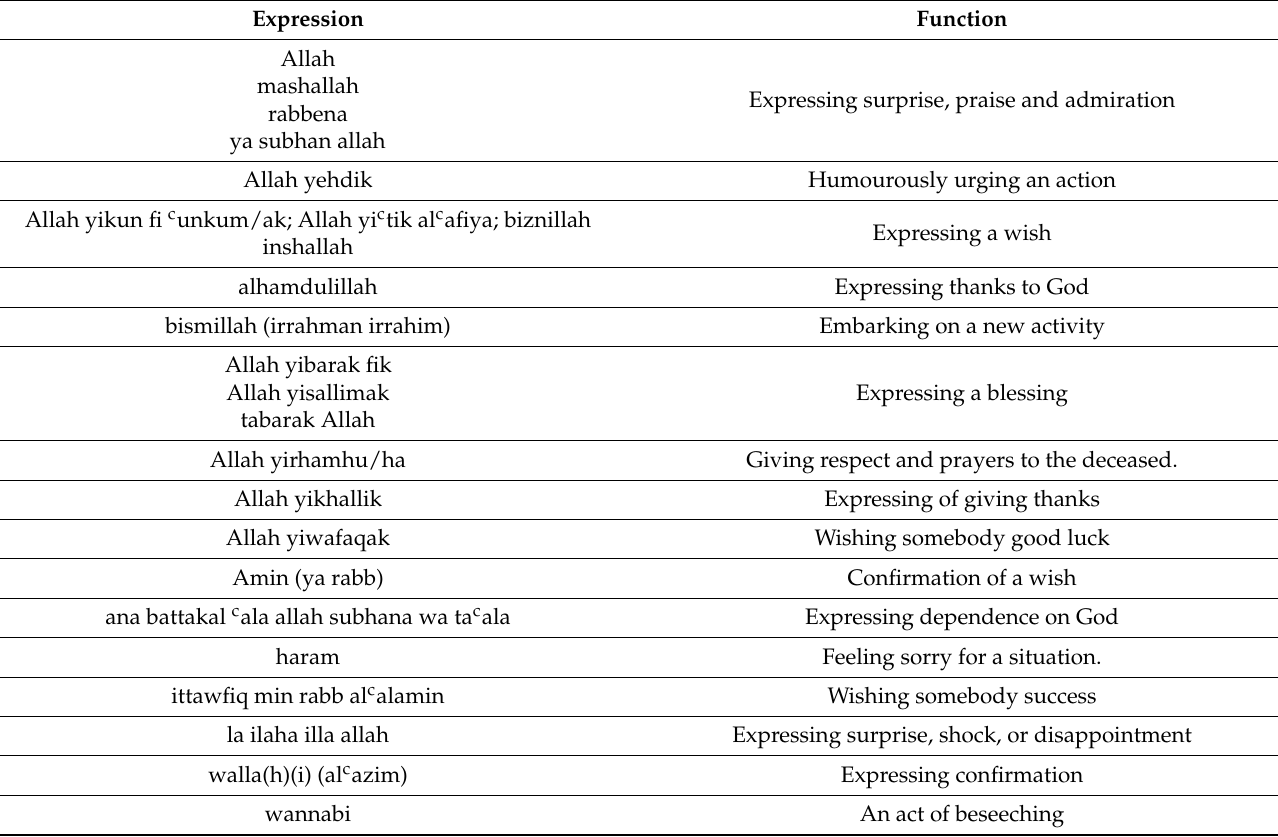
Table 10. Functions of the various